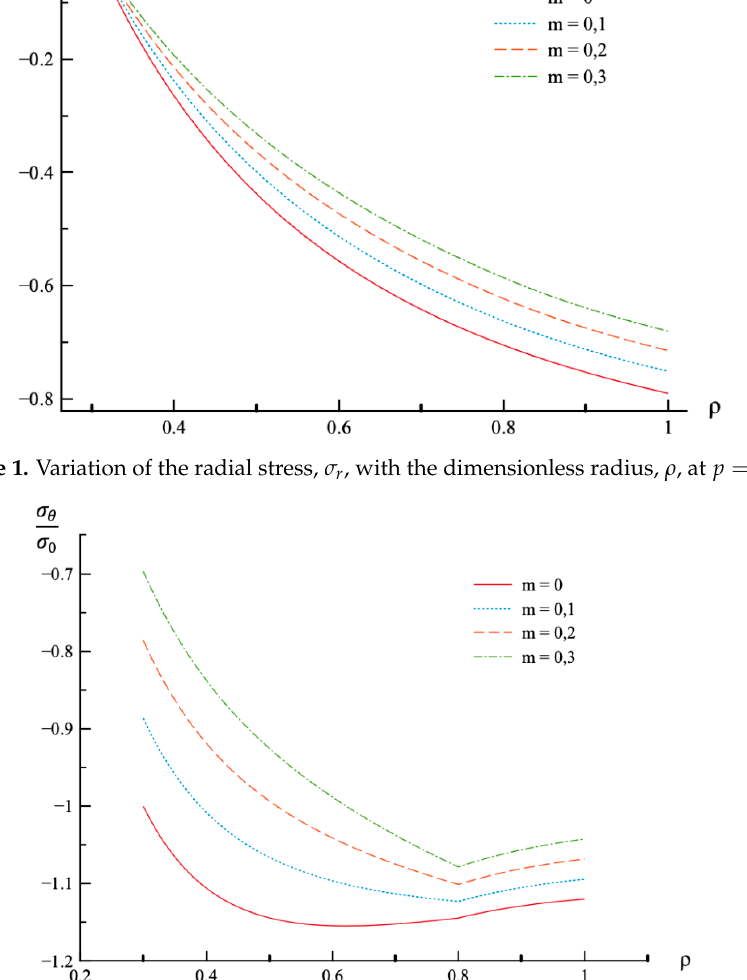
Figure 2. Variation of the circumferential stress, σ θ , with the dimensionless radius, ρ , at p = p f .